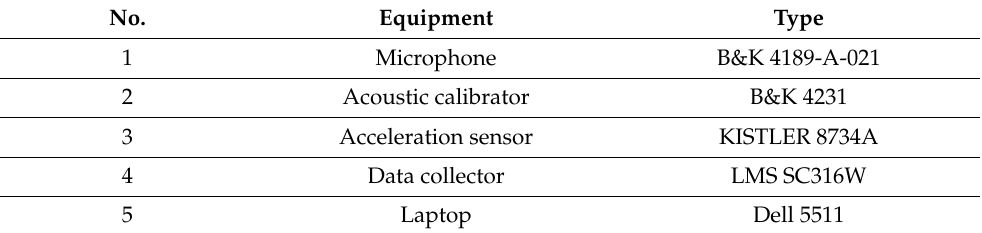
Table 3. Airborne noise source excitation measurement equipment.